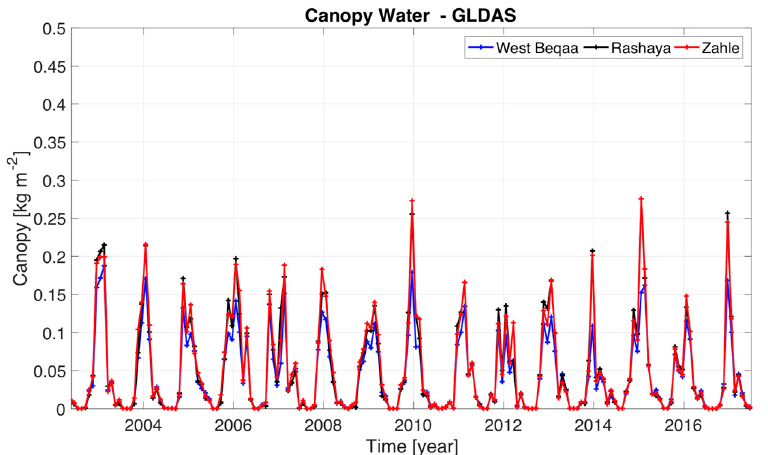
Figure 5. Canopy water (Canopy) from the GLDAS model simulations. Three separate regions are shown.